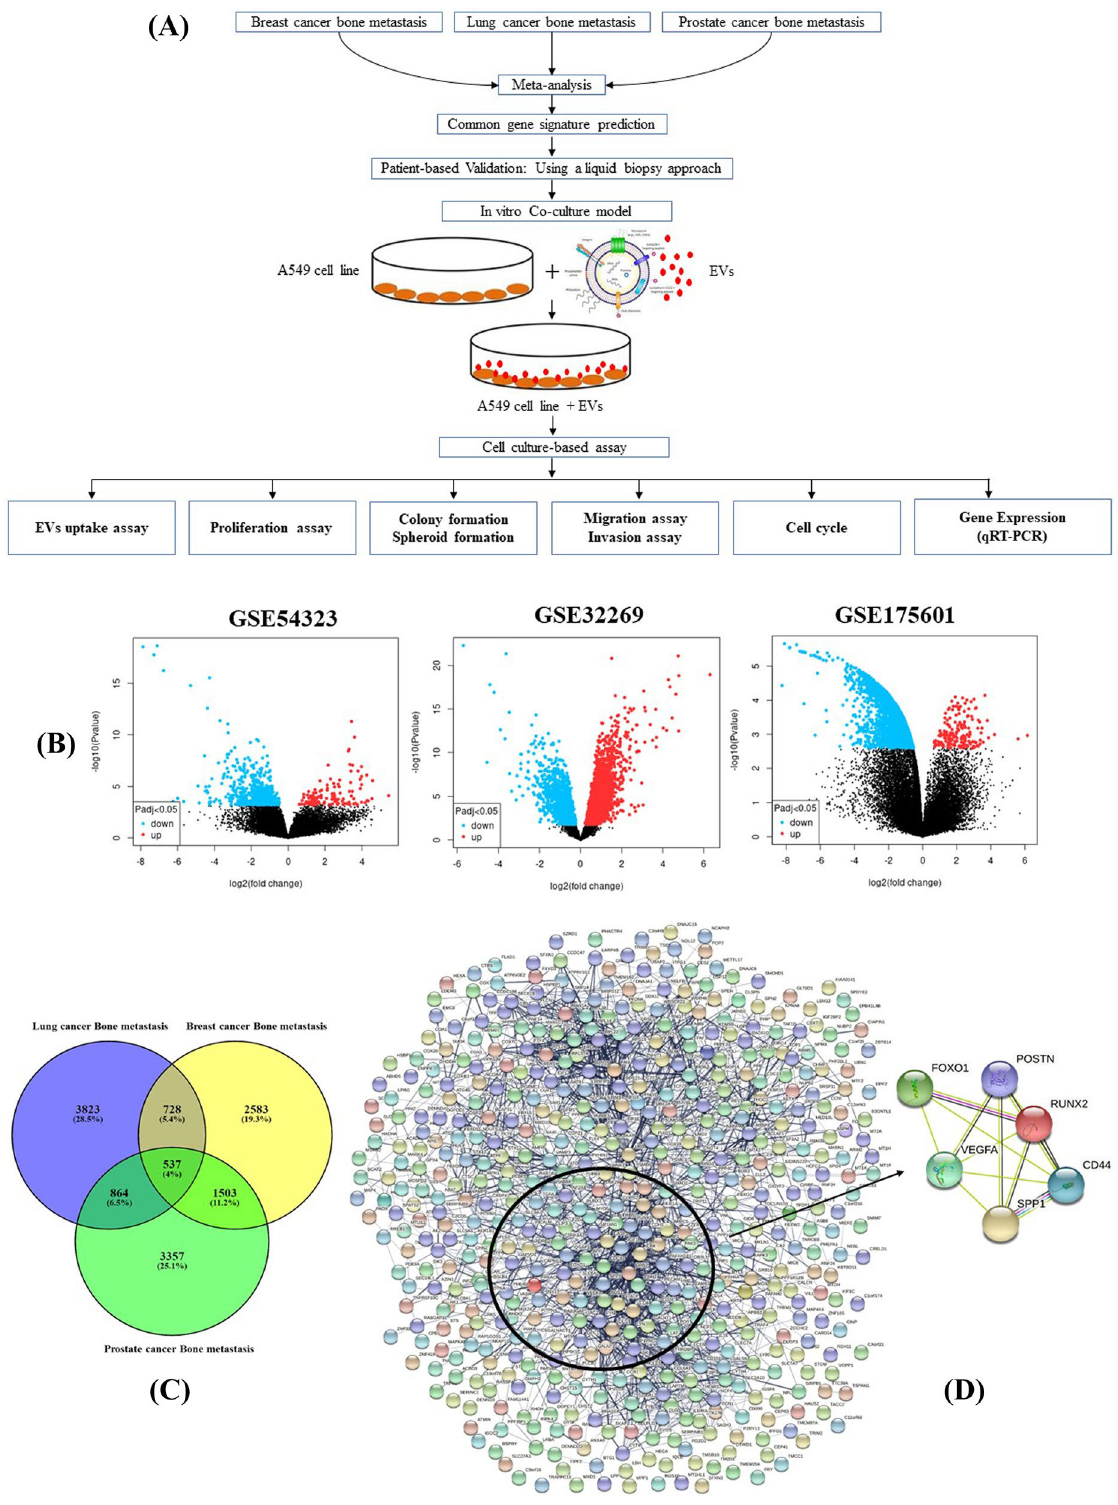
Figure 1. ( A ) The entire study workflow. ( B ) Volcanic plot of DEGs for four datasets: GSE54323, GSE32259, and GSE 175,601. Each dot represents an individual gene (Red dots presented upregulated genes with logFC > 2 and adj p value < 0.05, while blue dots presented downregulated genes with logFC < 1 and adj p value < 0.05). ( C ) Venn diagram representing the overlapping genes. Each of the circles represents a dataset of bone metastases with various primary tumors breast cancer, prostate cancer and lung cancer. ( D ) String protein interaction analysis. String output showing interaction of the common six genes ( SPP1 , VEGFA , FOXO1 , RUNX2 , CD44 and POSTN ) that are specific for bone